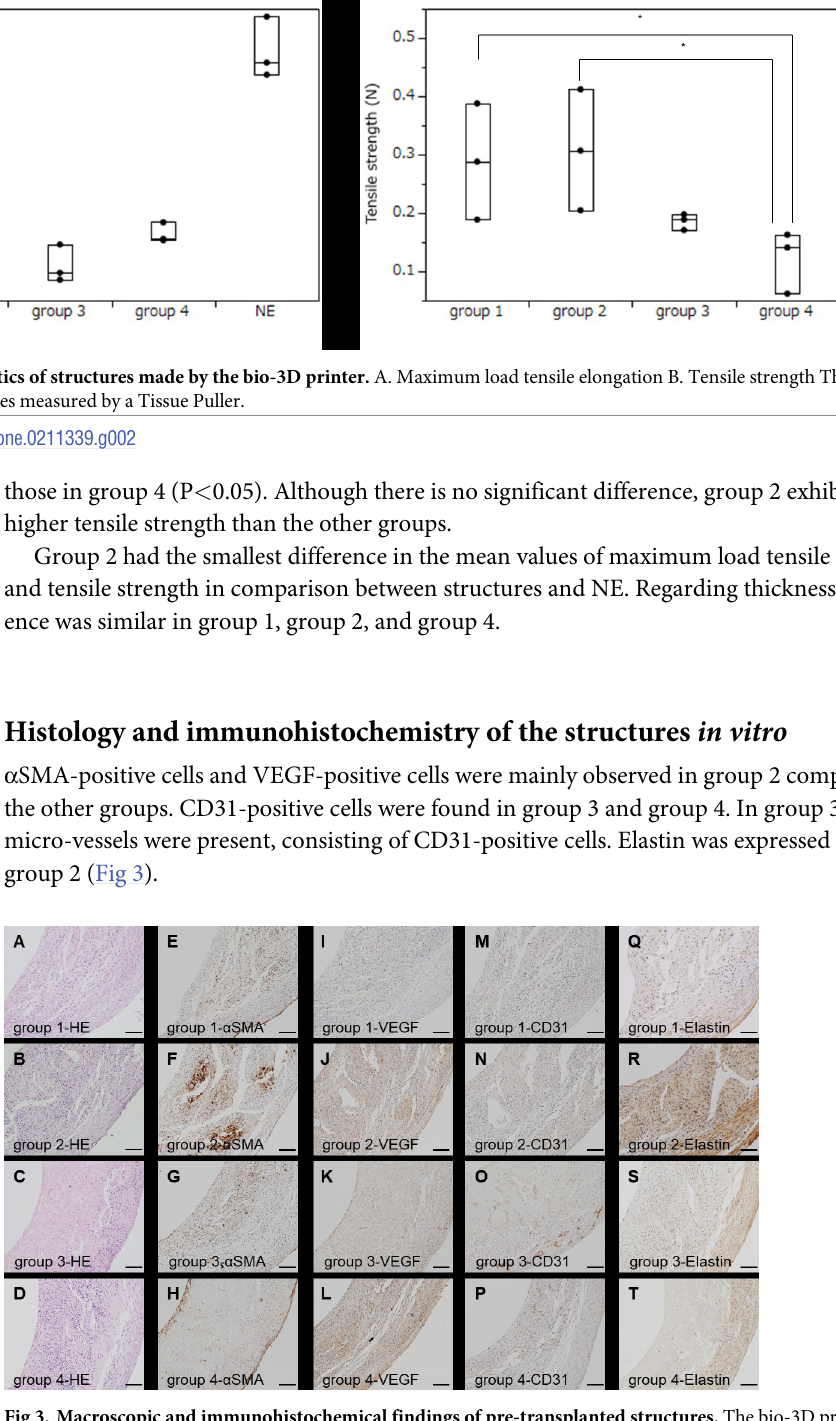
Fig 3. Macroscopic and immunohistochemical findings of pre-transplanted structures. The bio-3D printed structures are shown before transplantation. A-D: HE staining. E-H: Immunohistochemical staining with anti- α SMA antibodies. I-L: Immunohistochemical staining with anti-VEGF antibodies. M-P: immuno-histochemical staining with anti-CD31 antibodies. Q-T: Immunohistochemical staining with anti-elastin antibodies. Scale bar = 100 μ m. HE: hematoxylin-eosin, SMA: smooth muscle actin, VEGF: vascular endothelial growth factor.